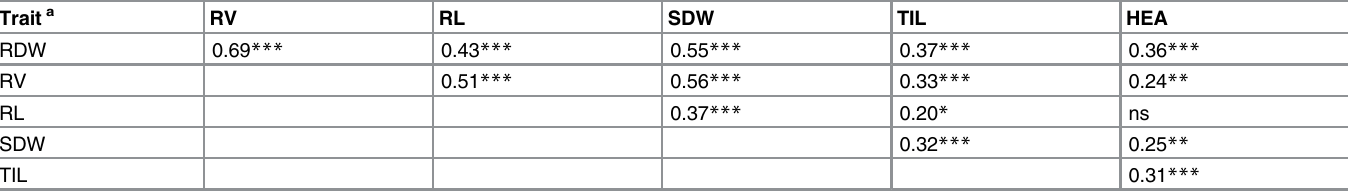
The QTL analysis revealed 16 putative QTL for shoot and root traits of which twelve and four QTL alleles were linked to the favorable performance of the exotic and elite alleles, respectively (Table 3). These QTL effects were localized on chromosomes 1H, 3H, 4H, 5H and 7H (Fig 1). Table 2. Correlation coefficients among the root and shoot traits in the F2 population. Trait